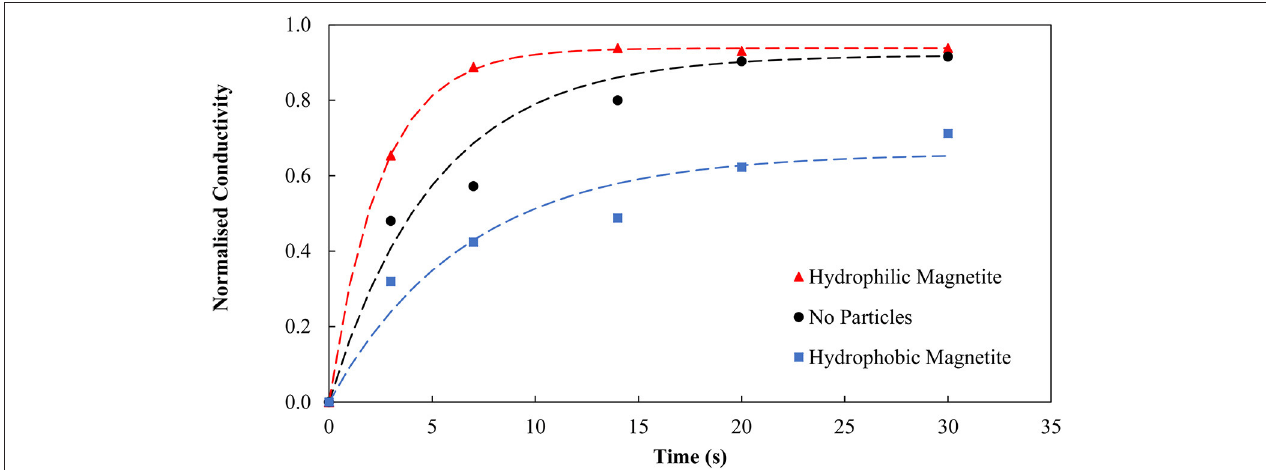
FIGURE 6 | Emulsion degradation over time for systems containing no particles, magnetite particles and conditioned magnetite particles. Here the magnetite particles produced the most degradation. Previously, in Figure 3 , the binder was present in excess hence the magnetite had less impact.